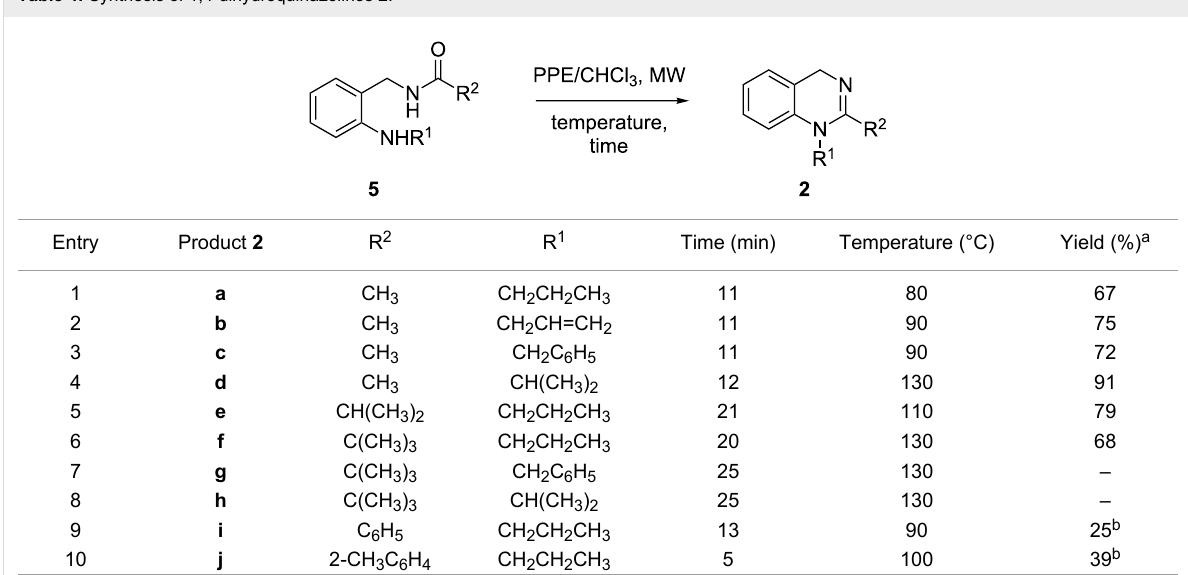
Table 4: Synthesis of 1,4-dihydroquinazolines 2